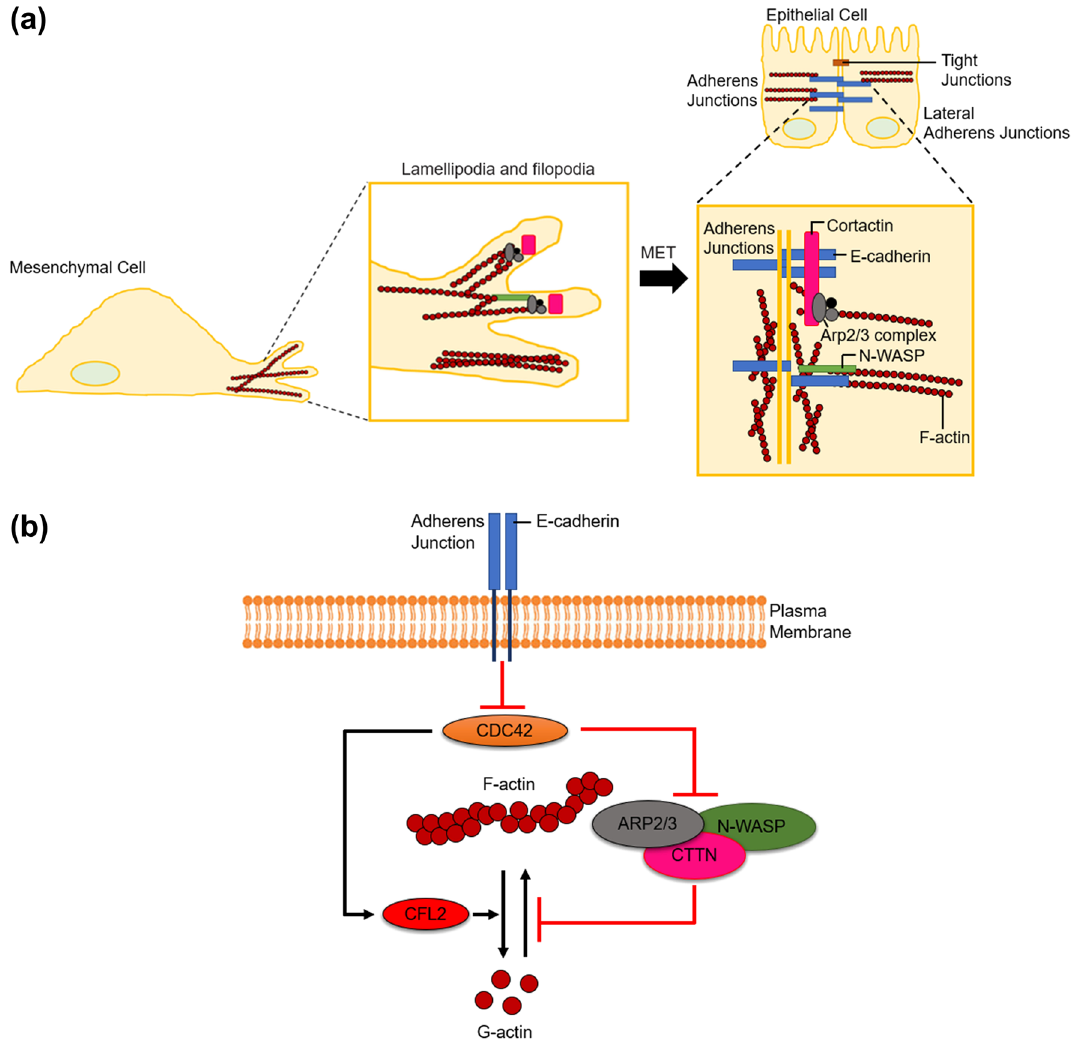
Figure 8. (a) In mesenchymal cells, E-cadherin is not present, and the actin cytoskeleton undergoes several changes, leading to a shift of actin and its regulatory proteins and complexes such as N-WASP, cortactin, and Arp2/3 complex from the cortex towards the leading edge to form lamellipodia. In contrast, epithelial cells form tight junctions to create an intracellular barrier separating the tissue from the outside world and adherens junction between adjacent cells that bestow mechanical stability by connecting with the actin cytoskeleton and E-cadherin. Furthermore, E-cadherin maintains adherens junction integrity by providing a basis for sequestration of actin nucleation proteins in non-motile cells. Cortactin, a scaffolding protein, binds to both N-WASP and E-cadherin to recruit Arp2/3 complex to adherens junctions, leading to a reduction in the expression of actin-regulatory proteins. (b) E-cadherin inhibits CDC42, a small GTPase of the Rho family, which in turn prevents actin interacting regulatory proteins (N-WASP, ARP2/3, and CTTN) from taking part in actin nucleation, at the same time stimulating the activity of actin severing protein CFL2, thereby promoting depolymerization of of MCF-7 cells compared to MM 231 cells were observed and reported earlier with as-received cells in a study conducted using AFM 19 . The bone scaffolds-derived MCF-7 cells appear softer and have a larger loss tangent (a measure of liquid-like behavior) than as-received MCF-7 cells (Figs. 2 and 4e). In contrast, elastic moduli and loss tangent values are similar for as-received and scaffolds-derived MM 231 cells (Figs. 3 and 4f). Earlier studies show that dysregula- tion in actin cytoskeletal dynamics is associated with increased liquidity or liquid-like behavior (represented by higher loss tangent). At the same time, elastic moduli increase with the stabilization of the F-actin network 89 . As received MCF-7 and MDA-MB231 cell lines have been previously investigated for their loss tangents 40 and more fluid like characteristics of MCF-7 as compared to as recieved MDA-MB-231 cell line is reported. Clearly, on arrival at the bone metastasis location, MCF-7 continues to have increased liquid like behavior while the MDA-MB-231 cells do not exhibit reduction in elastic modulus or liquid-like behavior over time. The inherently